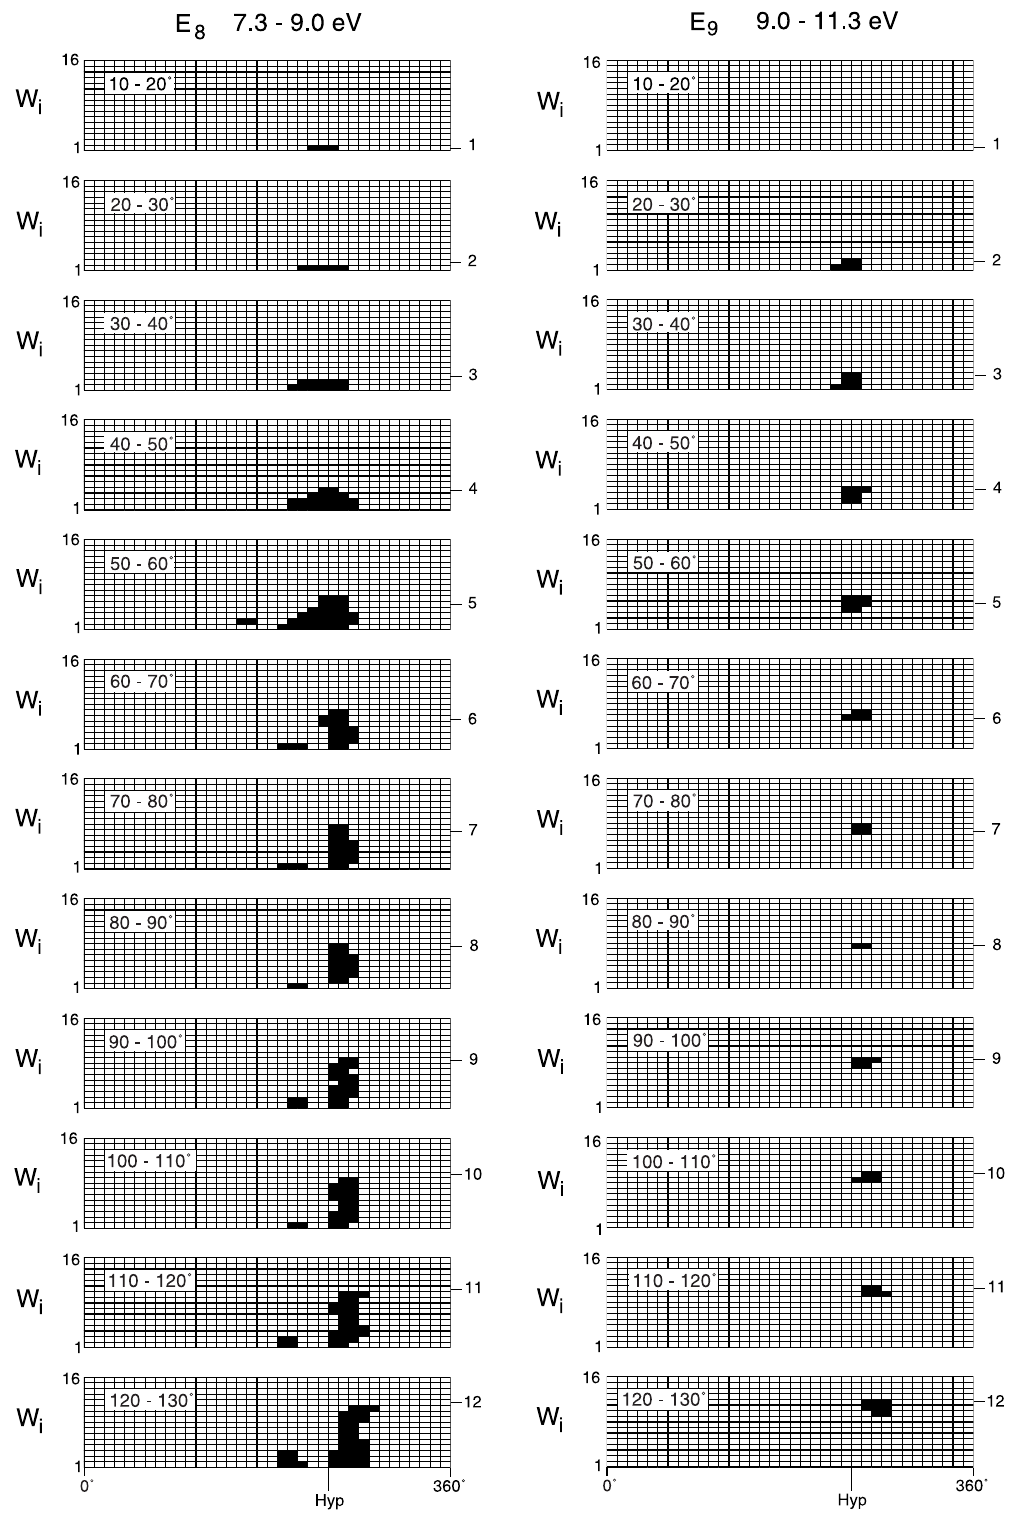
Fig. 6. Simulated maps of the possibility to detect ion beams during a spin period for various incoming beam directions at infinity and for two energy bands: 7.3–9.0eV (left) and 9.0–11.3eV (right). From top to bottom, each plot corresponds to an incoming polar angle of the ion beam. Inside each plot, black cells represent the possible arrival directions versus windows w i and azimuthal angle (or time since the satellite is rotating). The number in the right side of each plot denotes the window aligned with the incoming direction of the beam at infinity. The label “HYP” refer to the azimuthal angle of the